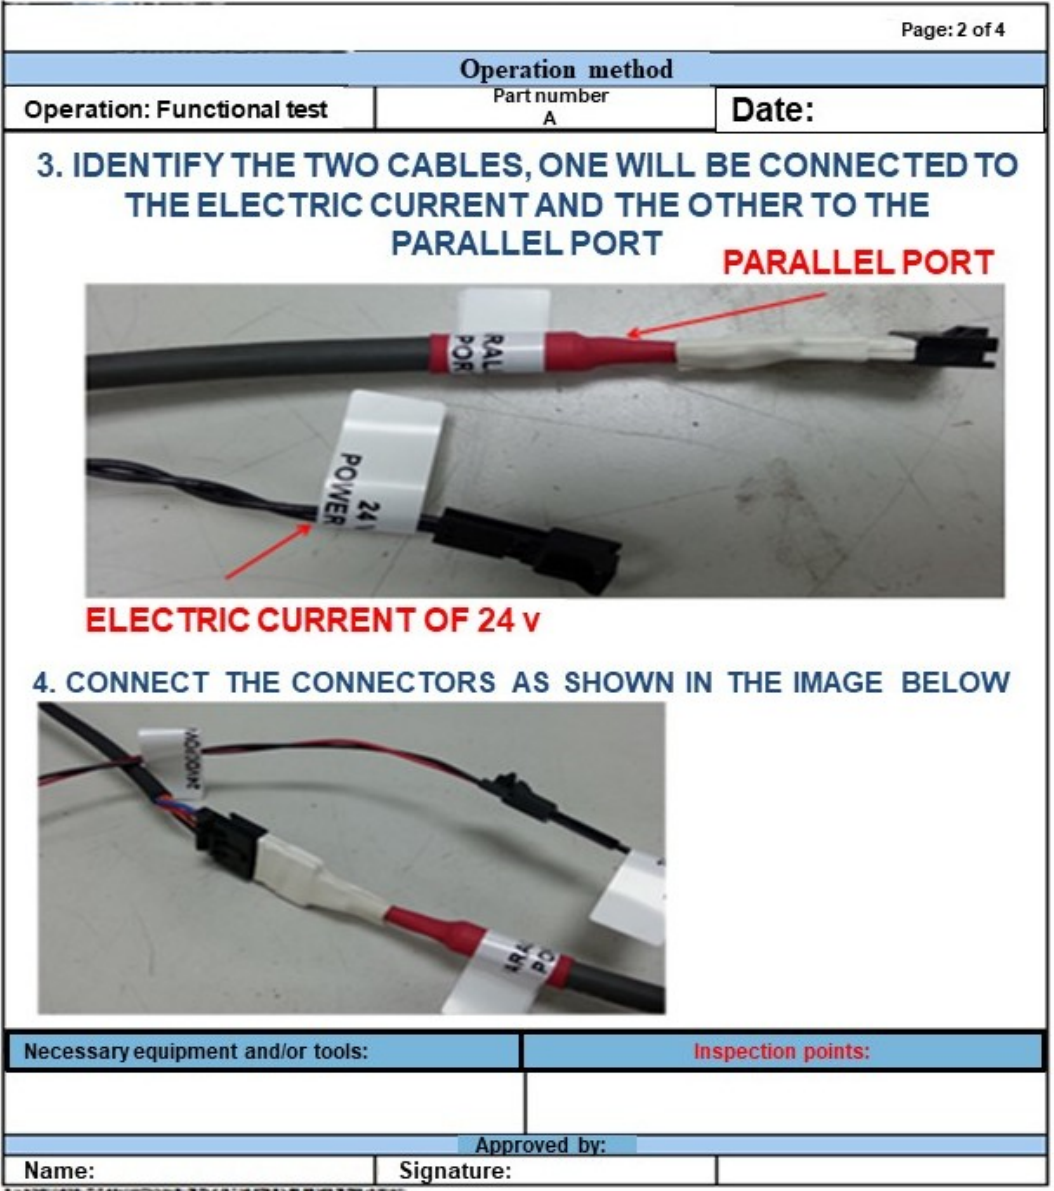
Figure 2. Second Visual Aid to Conducting the Functional Test. Figure A2. Second Visual Aid to Conducting the Functional